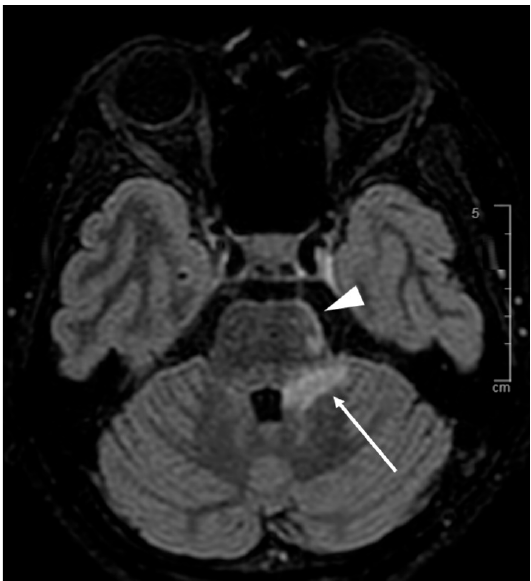
Figure 5. T2 FLAIR weighted sequence of brain magnetic resonance imaging evidencing pontomes- encephalic (white arrow head) and right cerebellar inflammatory lesions.